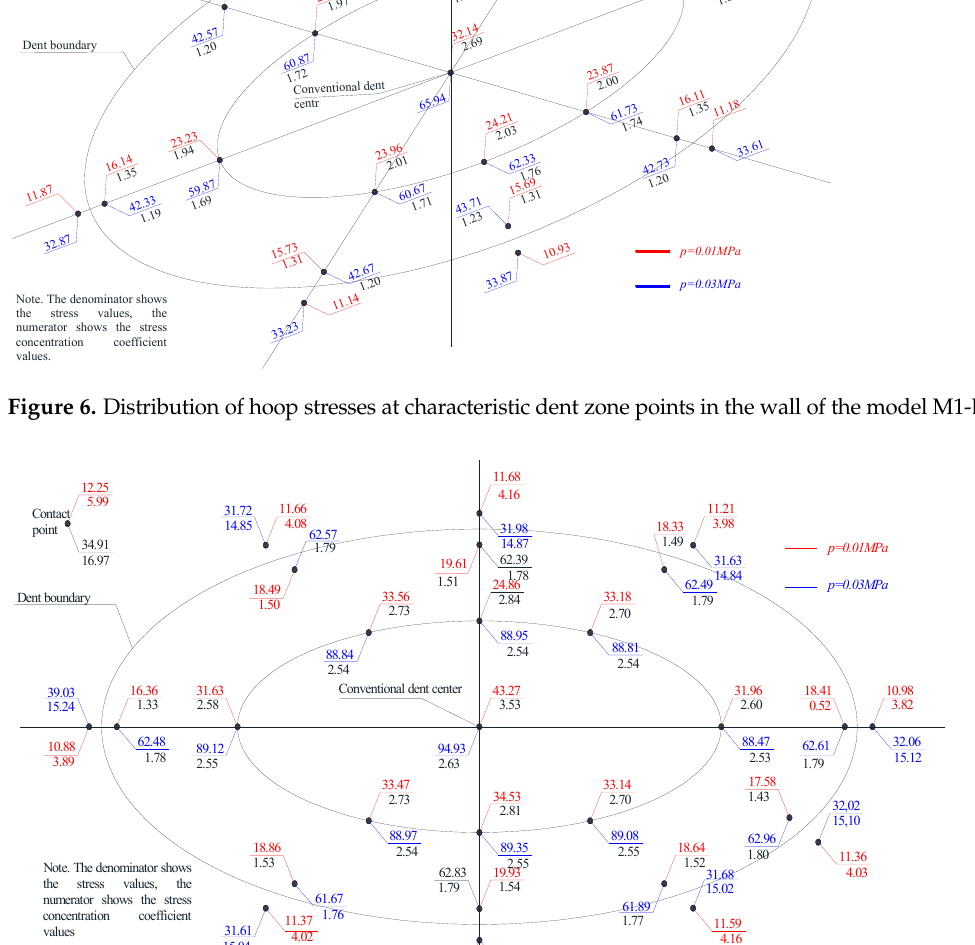
Figure 7. Distribution of hoop stresses at characteristic dent zone points in the wall of the model M2 ‐ A.